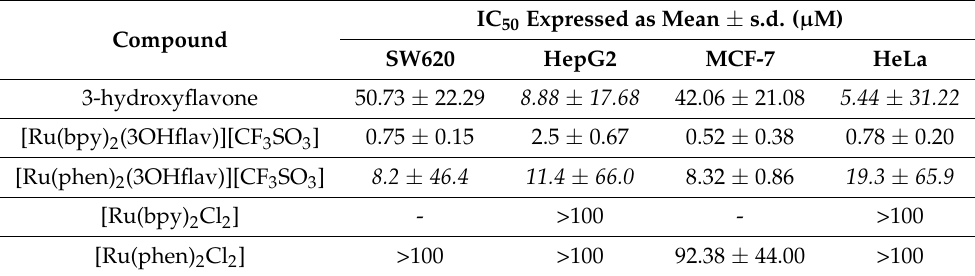
Table 1. Cytotoxicity of 3-hydroxyflavone and its ruthenium polypyridyl complexes against colorec- tal, liver, breast and cervix cancer cell lines. Data of Ru precursors is also shown, for